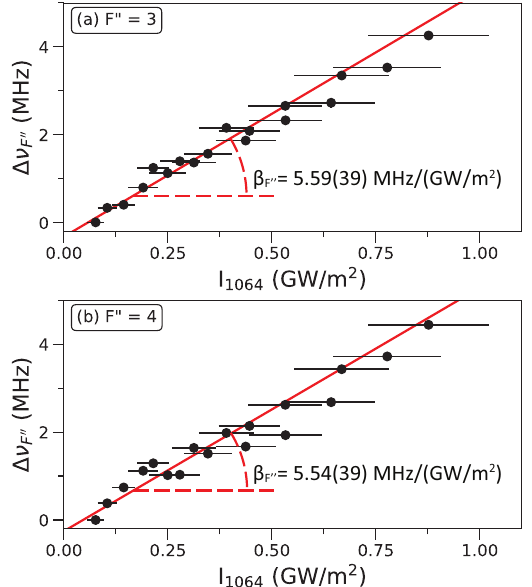
Figure 4. (Color online) ac Stark shifts, ν F (cid:48)(cid:48) , vs. I 1064 for F (cid:48)(cid:48) = 3 ( a ) and F (cid:48)(cid:48) = 4 ( b ). Dots with error bars are from experimental data. The solid lines are linear fits according to Equation